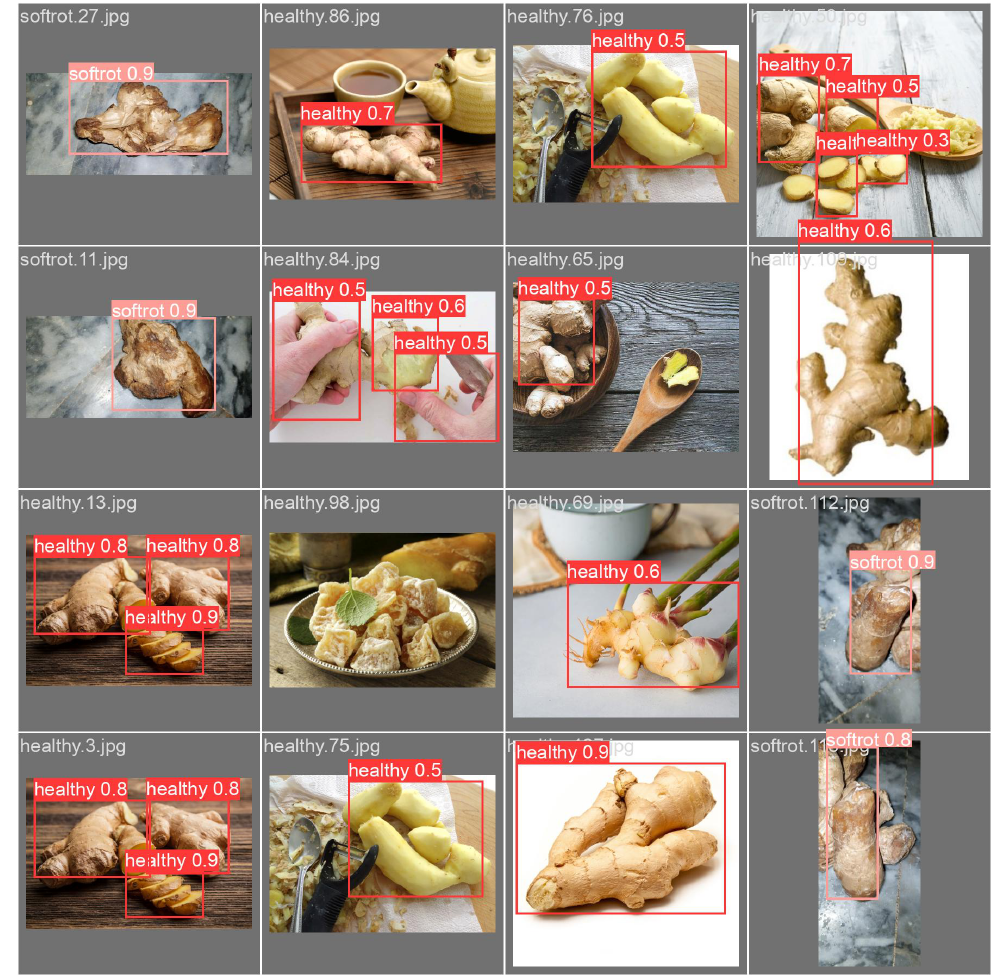
Figure 22. Set 2 of visual examples showcasing the qualitative evaluation of the YOLOv5 model on the ginger